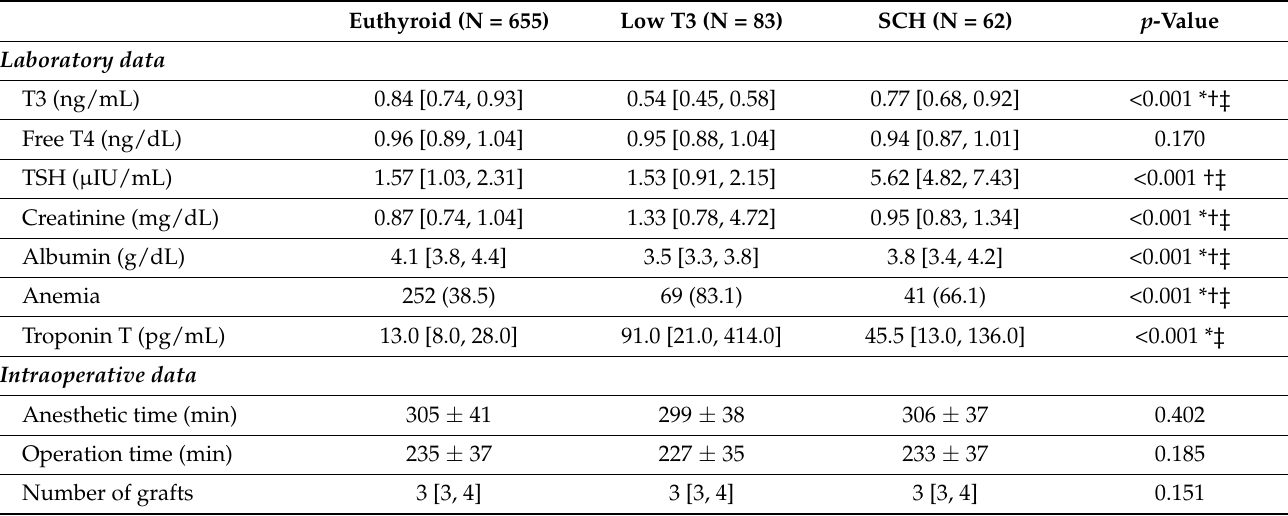
Table 2. Preoperative laboratory data and intraoperative data among the three groups, designated by thyroid function test.